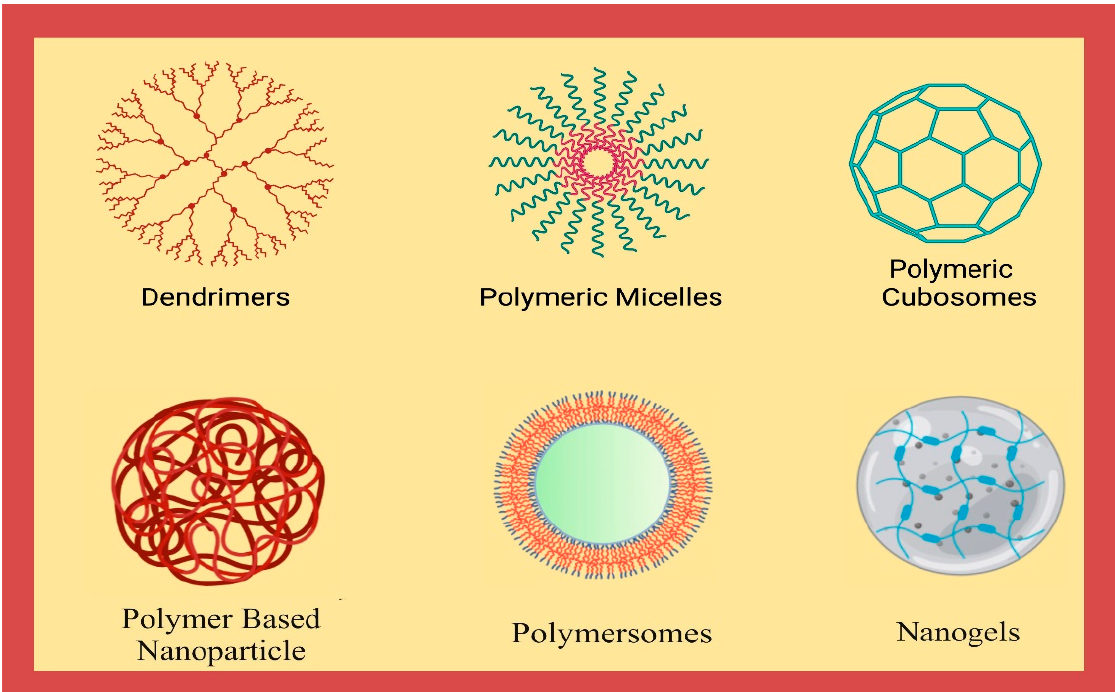
Figure 1. Diagrammatic representation of different polymeric nanocarriers.